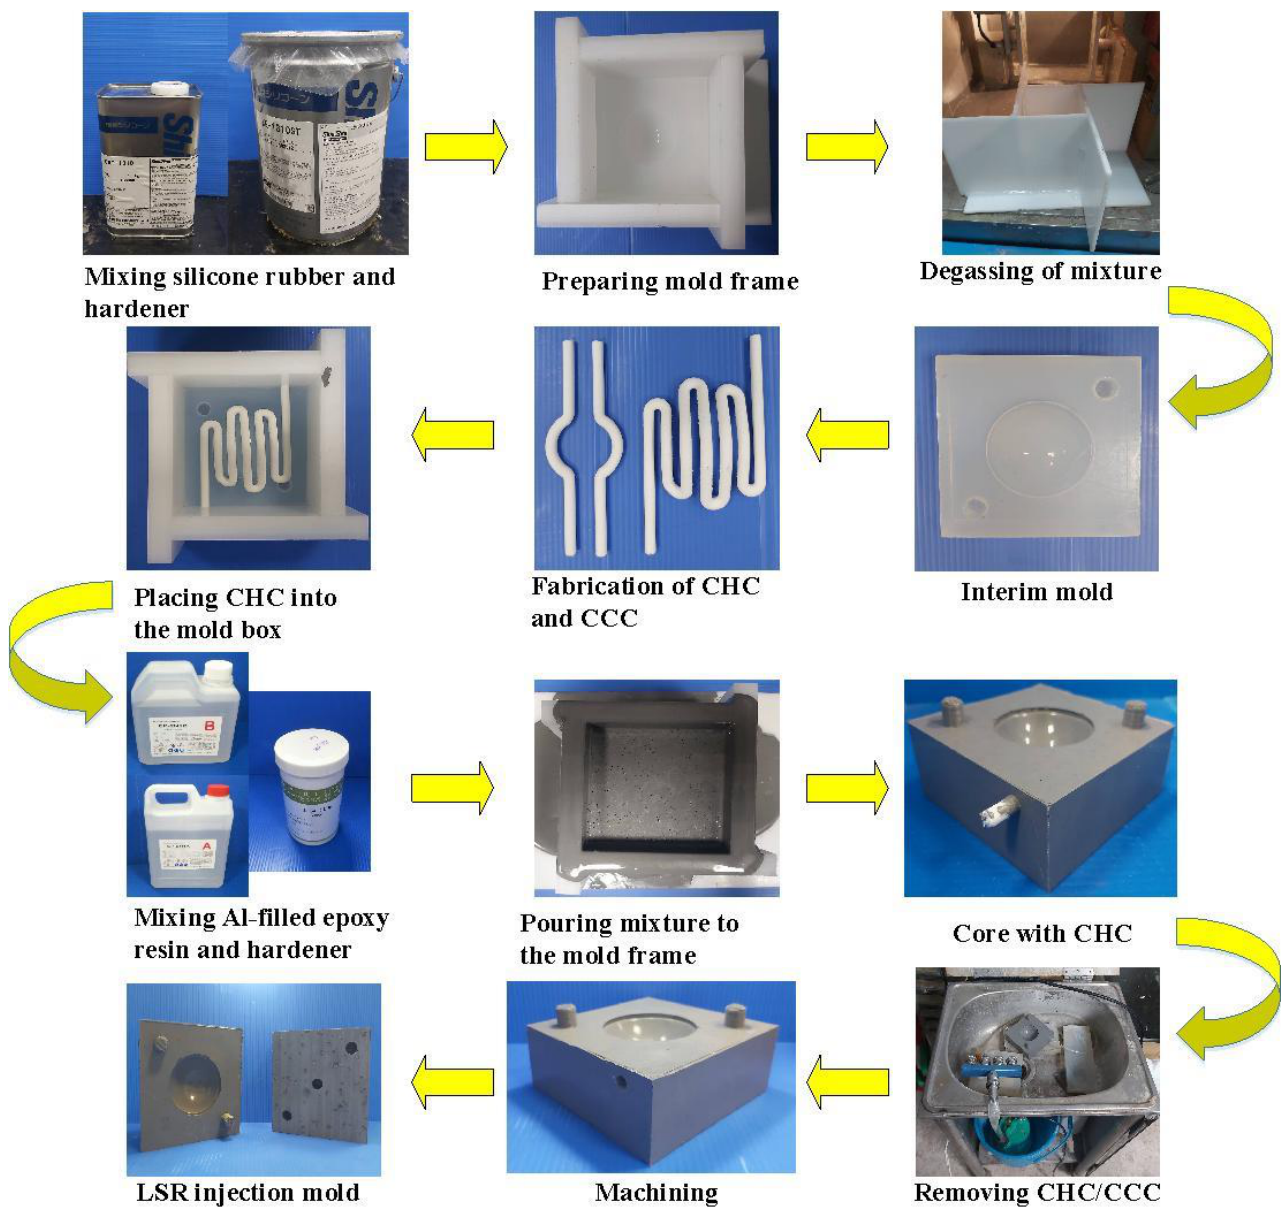
Figure 4. Manufacturing processes of LSR injection mold. Table 1. Process conditions used in the